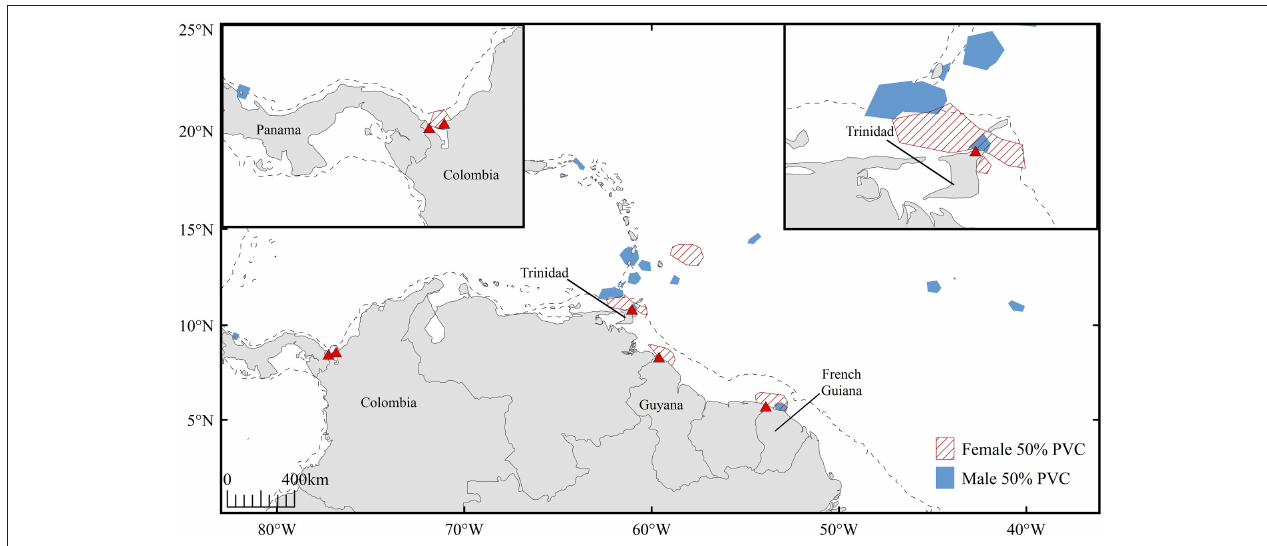
FIGURE 5 | High-use areas defined by 50% volume contours for mature male ( n = 12, blue) and female ( n = 6, red hatched) leatherbacks throughout the 45-day inferred mating period. Dashed line represents 200m